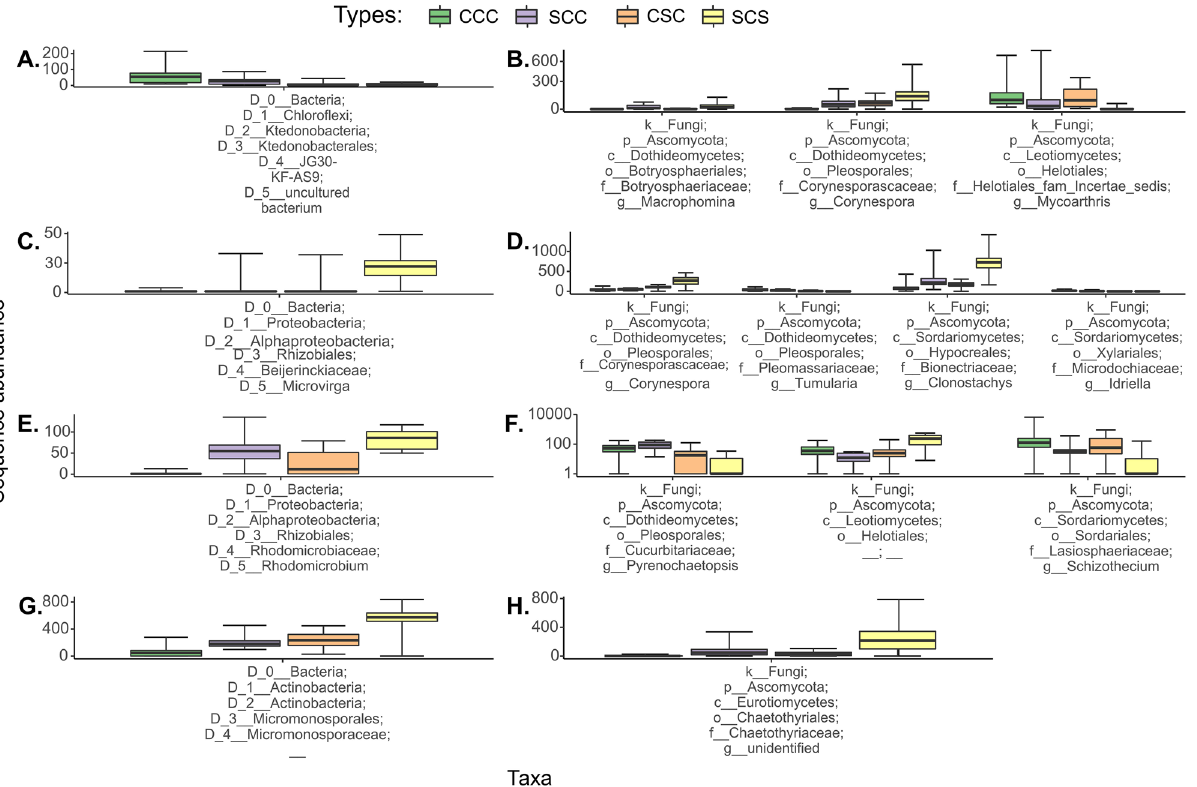
Figure 1. Differential abundance of taxa analyzed by ANCOM approach. Box-and-whisker plots of bacterial ( A ) and fungal ( B ) abundance at the Monmouth site, and bacterial ( C ) and fungal ( D ) abundance at the Urbana site associated with bulk soil; bacterial ( E ) and fungal ( F ) abundance at the Monmouth site, and bacterial ( G ) and fungal ( H ) abundance at the Urbana site associated with roots are shown with relative abundance distributions for the taxa that varied significantly among rotation